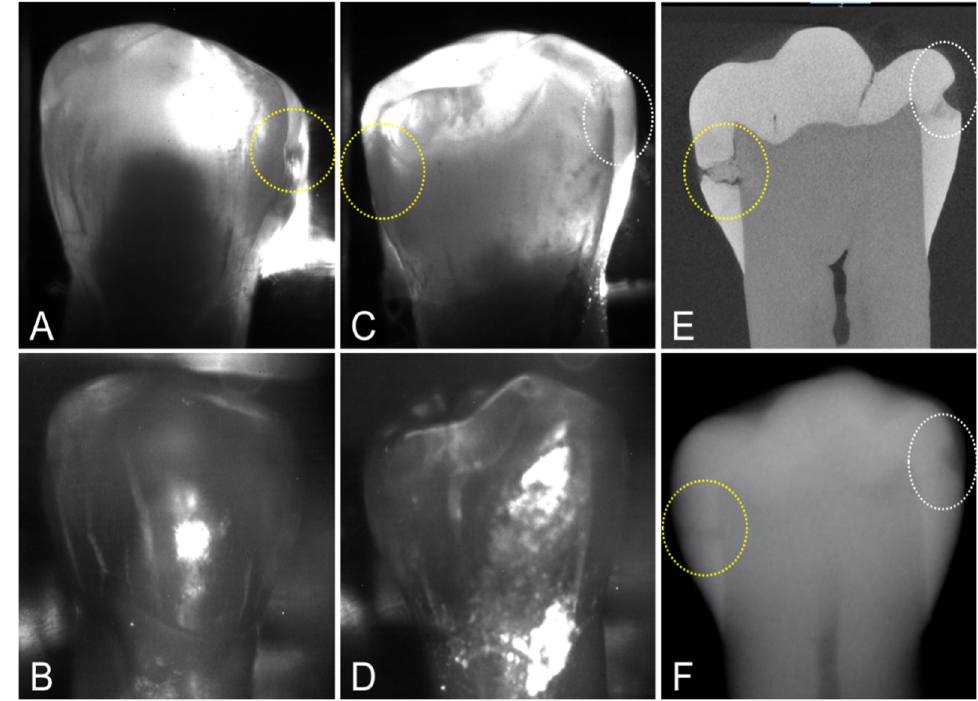
Figure 3. Proximal transillumination and reflectance images of a tooth with two interproximal lesions on opposing proximal surfaces. Lesion 1 (yellow circle) is more severe and penetrates to the dentin while lesion 2 (white circle) is limited to the enamel. ( A ) Transillumination and ( B ) Reflectance images with the imager on the buccal side of the tooth. ( C ) Transillumination and ( D ) Reflectance with the imager on the lingual side of the tooth. ( E ) MicroCT slice ( F ) and Dental X-Radiograph are also shown. Neither lesion is visible in the proximal reflectance images.